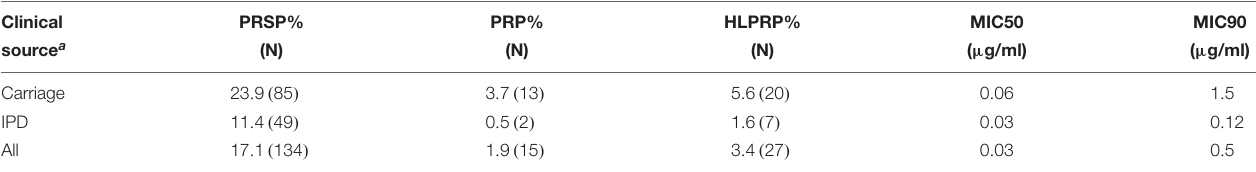
FIGURE 2 | Distribution over time of capsular types included in the 10-valent pneumococcal conjugate vaccine (PCV10; in green), of those included only in the 13-valent pneumococcal conjugate vaccine (PCV13; in yellow) and of those not included in any PCV currently available [non-vaccine (NV), in black]. (A) Distribution among 355 Streptococcus pneumoniae isolates recovered from asymptomatic carriers. (B) Distribution among 428 S. pneumoniae isolates recovered from patients with IPD. 10-valent PCV includes serotypes 1, 4, 5, 6B, 7F, 9V, 14, 18C, 19F, and 23F; 13-valent PCV also includes 3, 6A, and 19A. TABLE 2 | Distribution of Streptococcus pneumoniae isolates with reduced susceptibility to penicillin (PRSP), resistant to penicillin (PRP), and high-level resistant to penicillin (HLPRP) according to the clinical